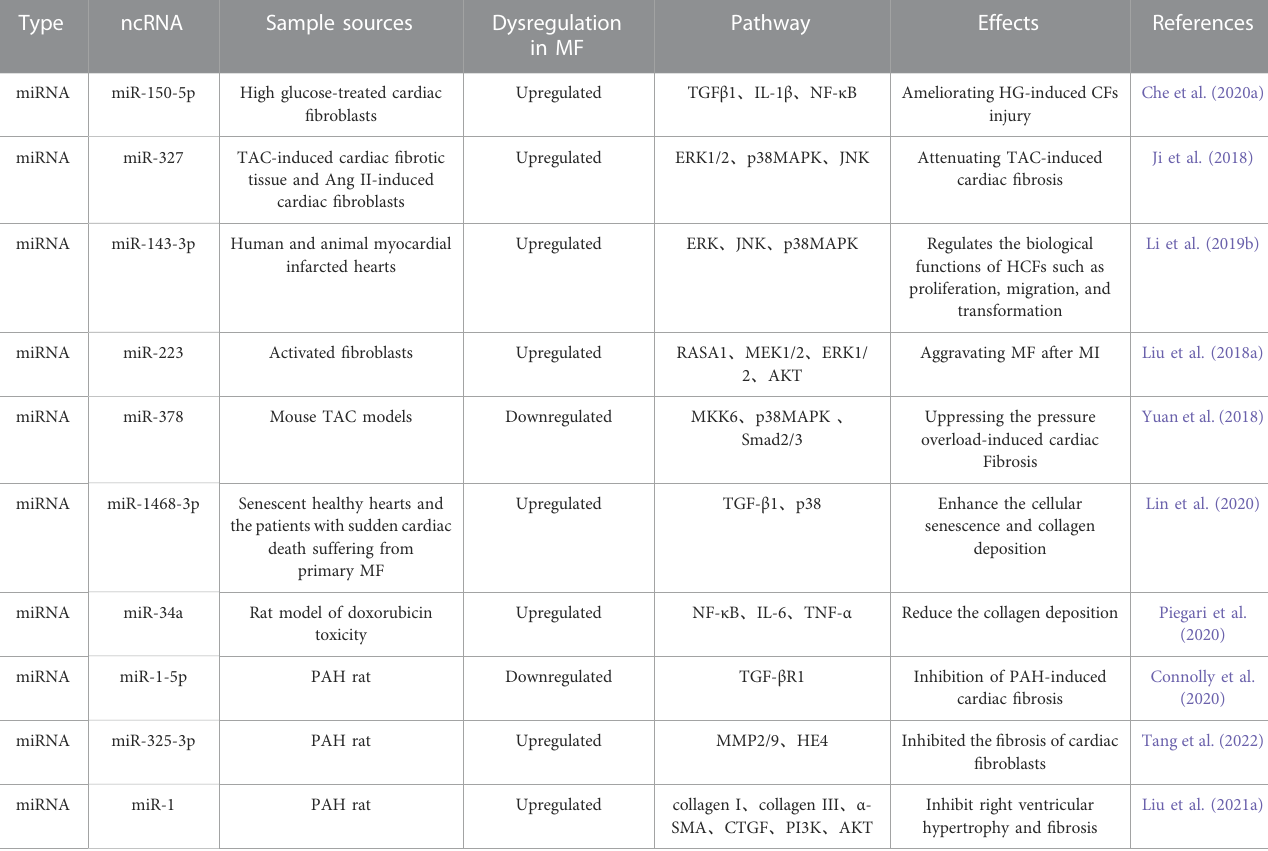
TABLE 1 ( Continued ) Mechanism of miRNA regulating TGF signaling